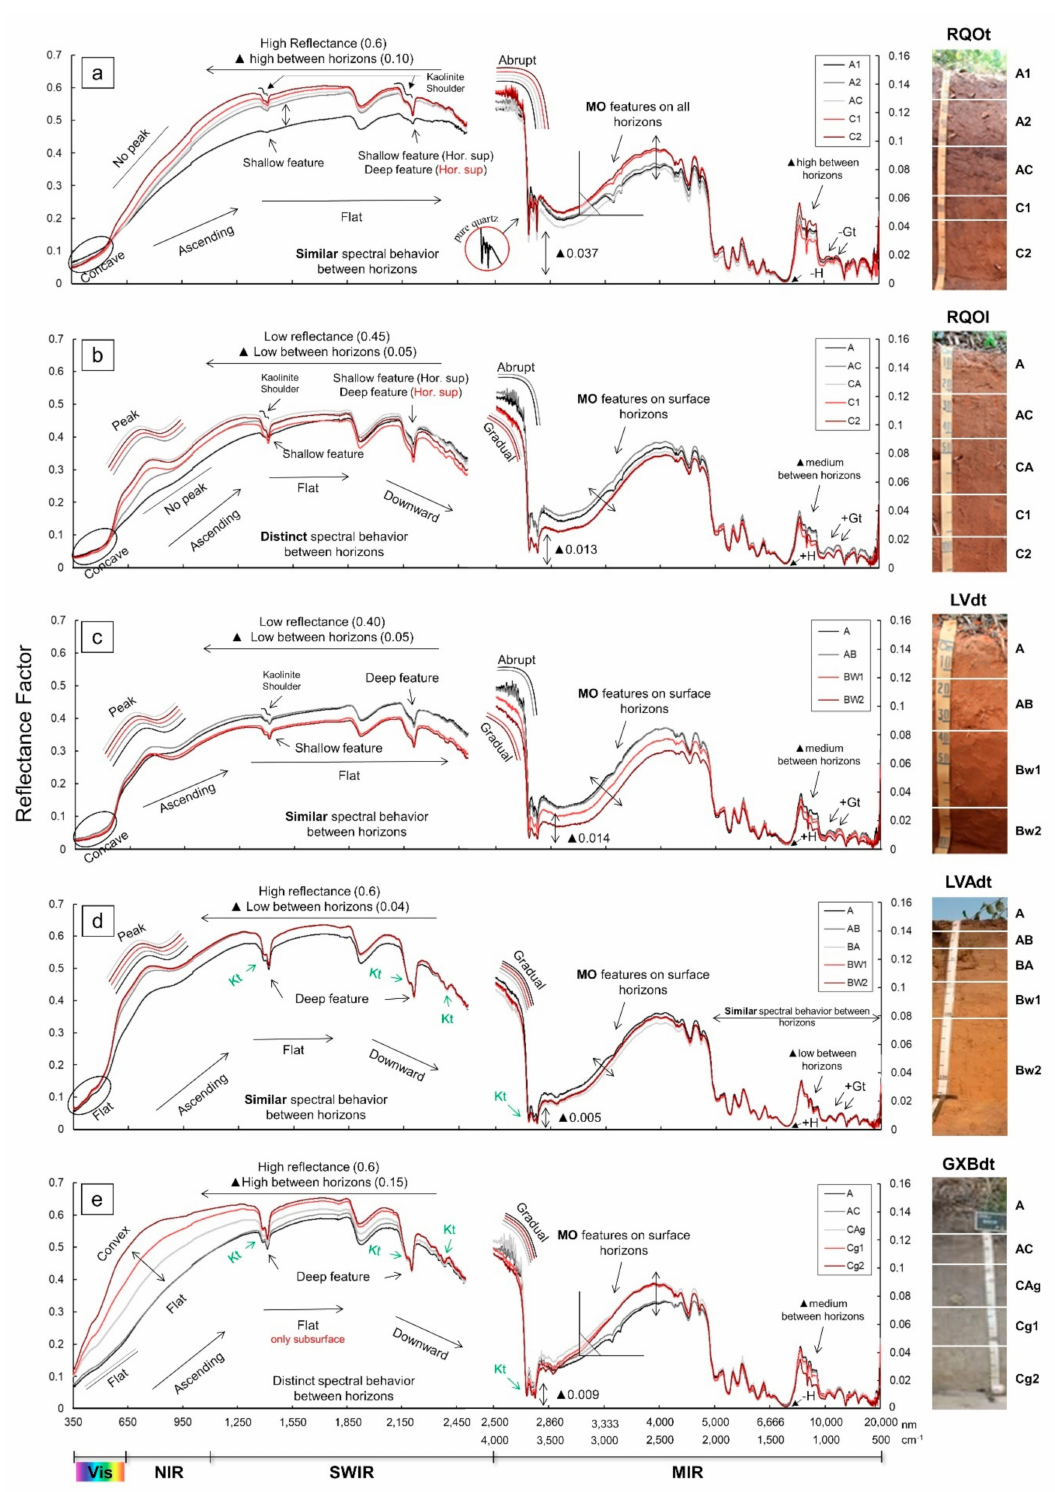
Figure 3. Spectral patterns of the different soil classes studied. They were categorized according to the MIRS methodology, proposed RQOt, Neossolo Quartzar ê nico Ó rtico t í pico ( a ); RQOl, Neossolo Quartzar ê nico Ó rtico latoss ó lico ( b ); LVdt, Latossolo Vermelho Distr ó fico t í pico ( c ); LVAdt, Latossolo Vermelho Amarelo Distr ó fico t í pico ( d ); and GXBdt, Gleissolo H á plico Tb Distr ó fico t í pico ( e